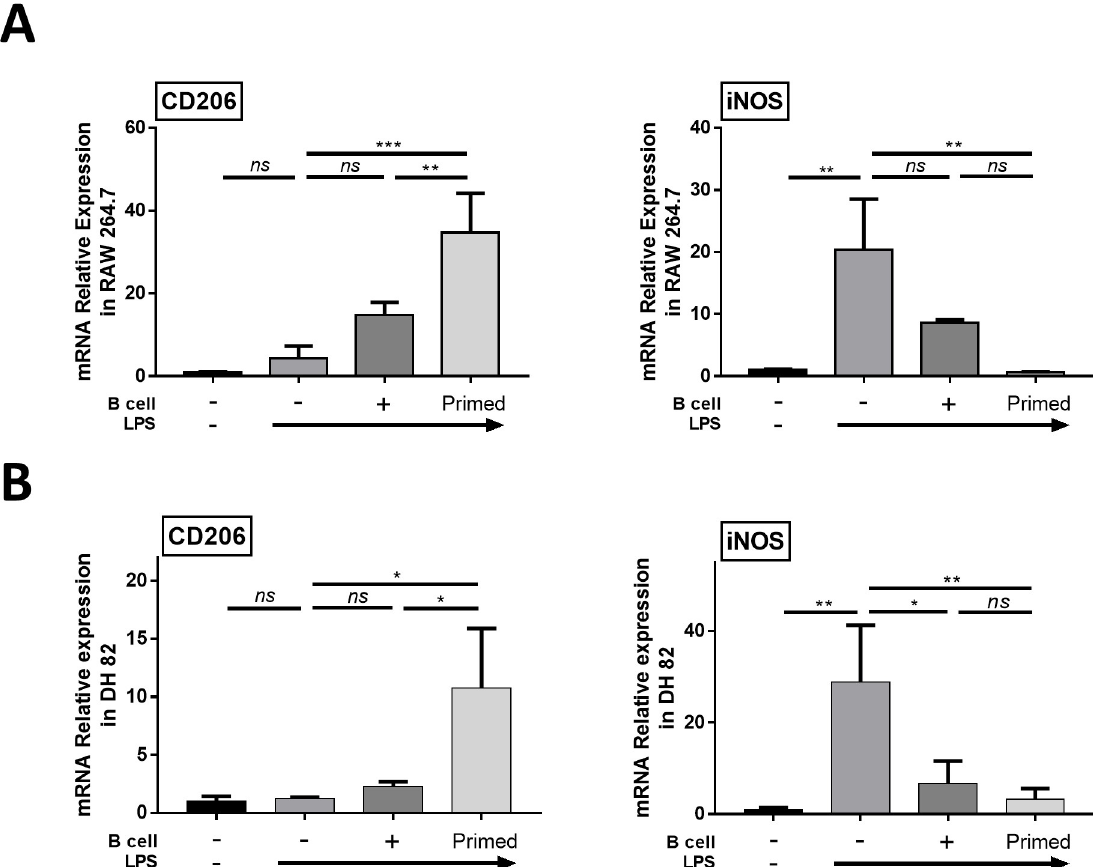
Fig 4. Primed B cells induced the expression of M2 macrophage markers in RAW 264.7 cells and DH82 cells. LPS stimulated RAW 264.7 and DH82 cells were co-cultured with primed B cells for 48 h. (A) Relative mRNA expression levels of CD206 and iNOS in RAW 264.7. (B) Relative mRNA expression level of CD206 and iNOS in DH82. Data are shown as mean ± standard deviation of three independent experiments ( ns = Not Statistically Significant, � P < 0.05, �� P < 0.01, ��� P < 0.001 by one-way ANOVA